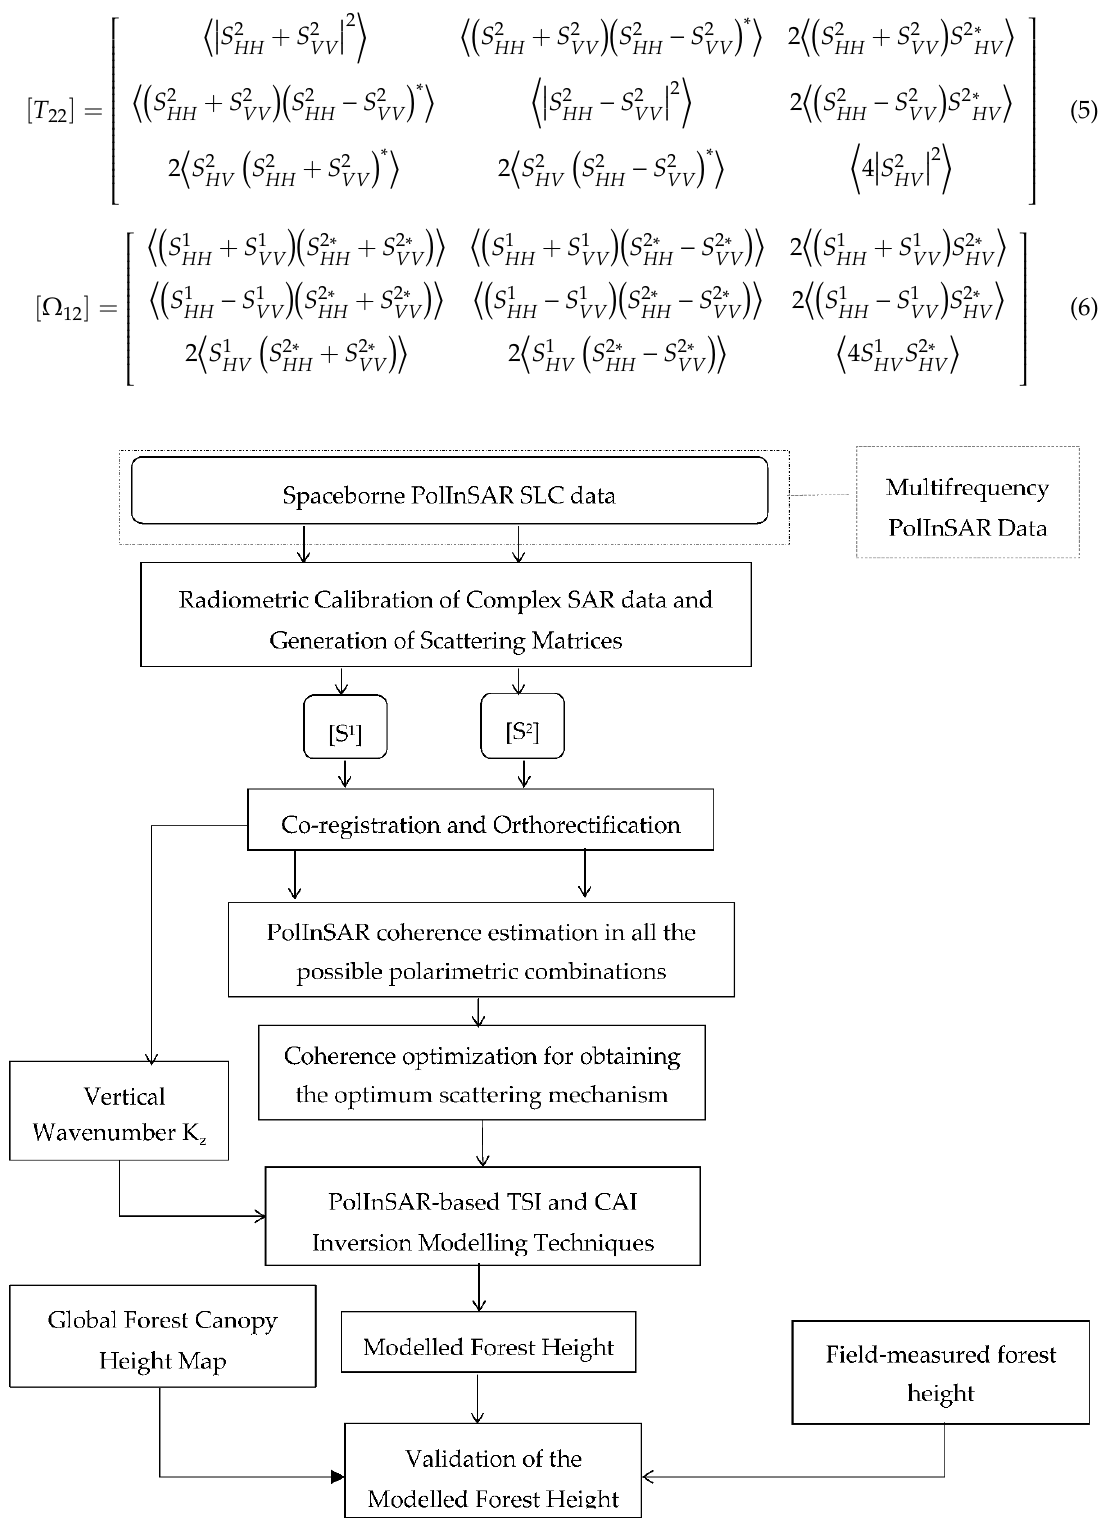
Figure 8. Methodology for PolInSAR inversion modelling for forest height retrieval.